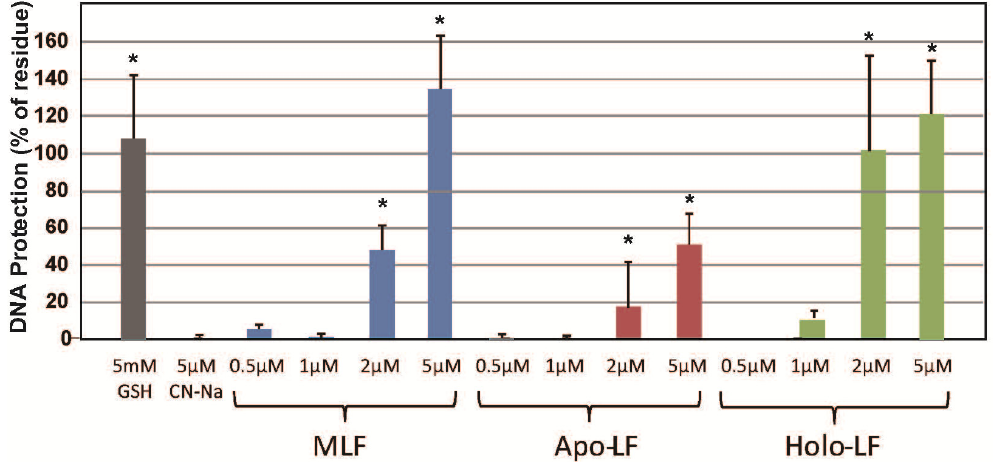
O system. The effects of 2 2 O in the presence of various test 2 2